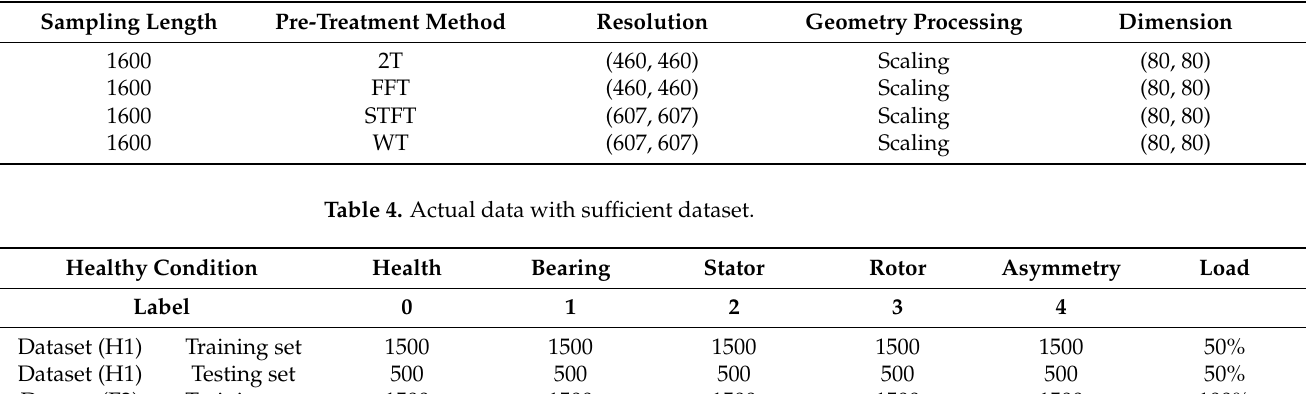
Table 3. Signal Pre-Processing.